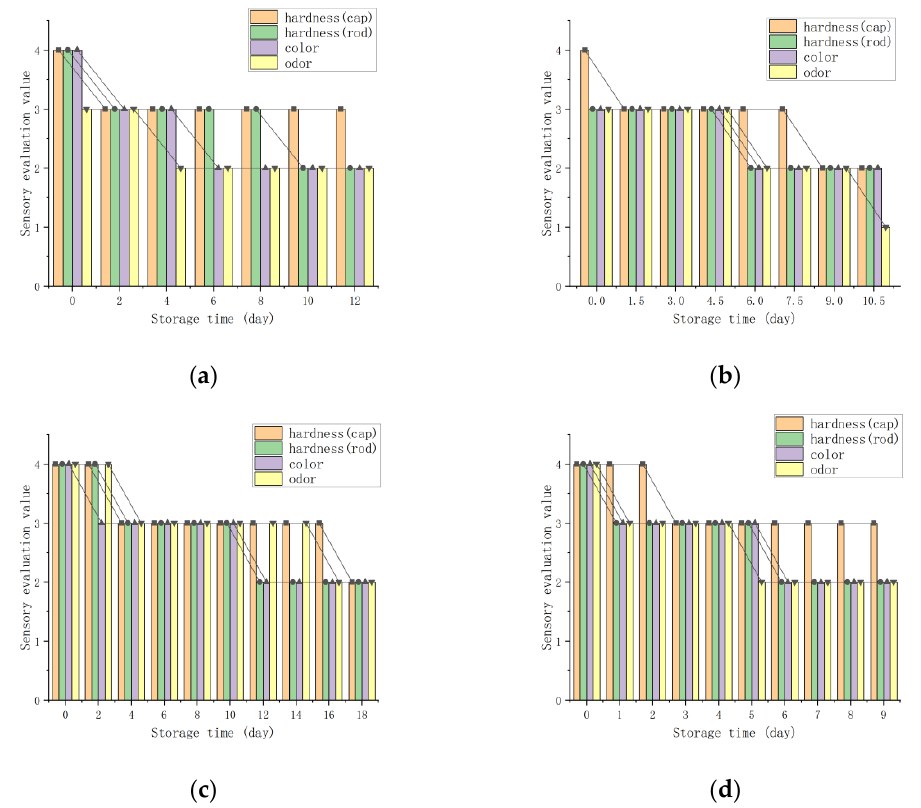
Figure 6. Matsutake sensory evaluation indicator changes with the different packaging methods: ( a ) refrigeration preservation packaging at 0 °C; ( b ) refrigeration preservation packaging at 4 °C; ( c ) modified atmosphere packaging; ( d ) preservative preservation